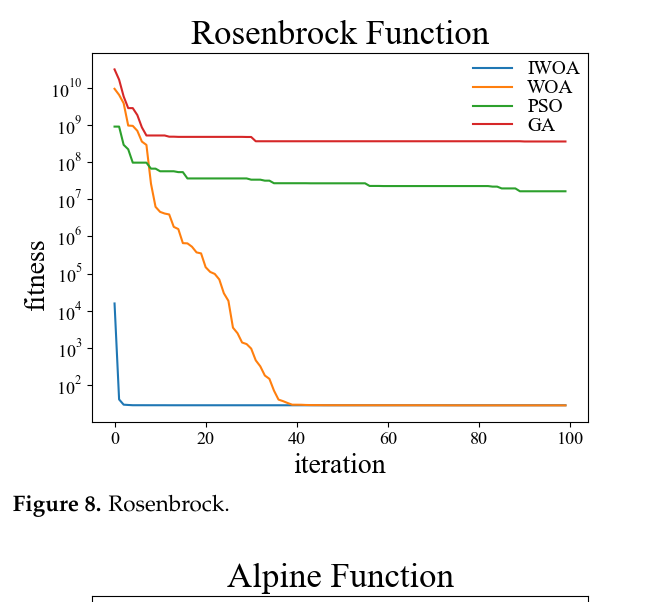
Figure 8. Rosenbrock.